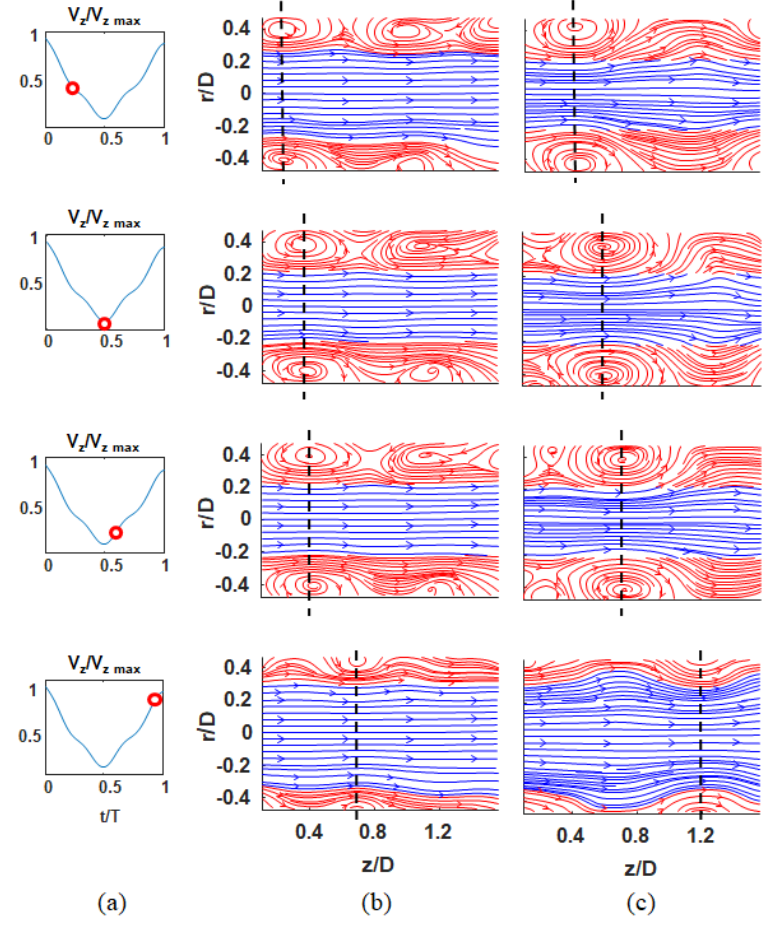
Figure 7: (a) Axial velocity profile at z = 0 and r = 0 and time at which the velocity field was obtained (red circles); (b) streamlines derived from experimental data for ¯ Re = 654, with d 0 = 1.6 cm; (c) streamlines derived from experimental data for ¯ Re = 1106, with d 0 = 1.6 cm. In both cases, red streamlines represent the recirculation zone and blue streamlines the central jet (colours available online